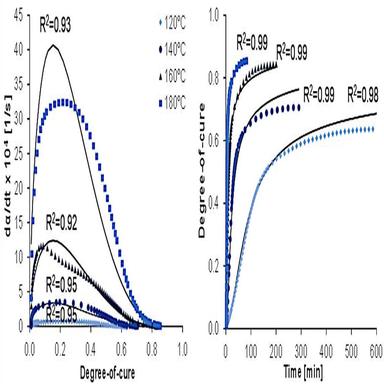
Cure rate vs. degree-of-cure (left) and degree-of-cure vs. time (right) with model predictions (solid line) of cyanate ester RS-3 (baseline). (For interpretation of the references to colour in this figure legend, the reader is referred to the web version of this article.)